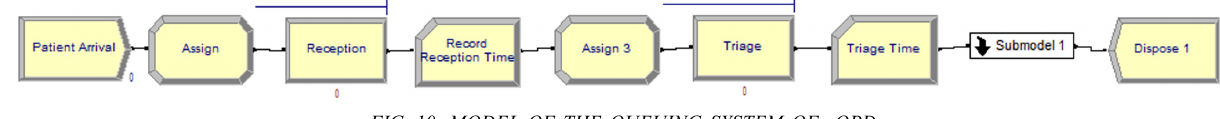
FIG. 10. MODEL OF THE QUEUING SYSTEM OF OPD